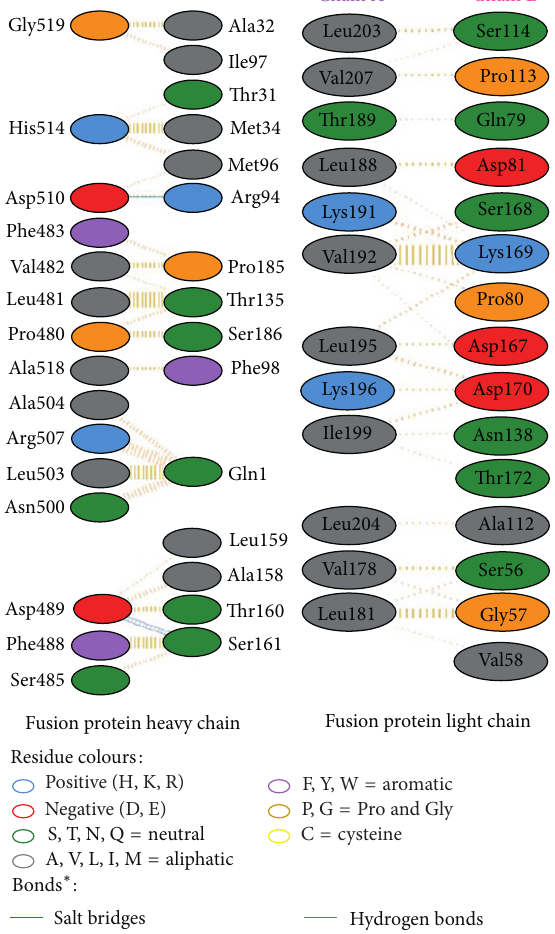
PPVAYLTPFVG from PGPTVFPAVLY and AEKREKQE from KREAKQEE (derived from motavizumab and small hydrophobic protein interaction) were the most stable in terms of potential energy as represented in supplementary figure (see Supplementary Material available online at http:// dx.doi.org/10.1155/2014/613293). Among them, the oligopep- tides which are the most stable and have good water solu- bility were GEKKLVEAPKS, PDAPSQNDGKDSSTV, YHT- GSSVSLTSPSLGEVKE, and AEKREKQE; hydropathy plot in Figure 9 represents top region as hydrophilic and bottom region as hydrophobic